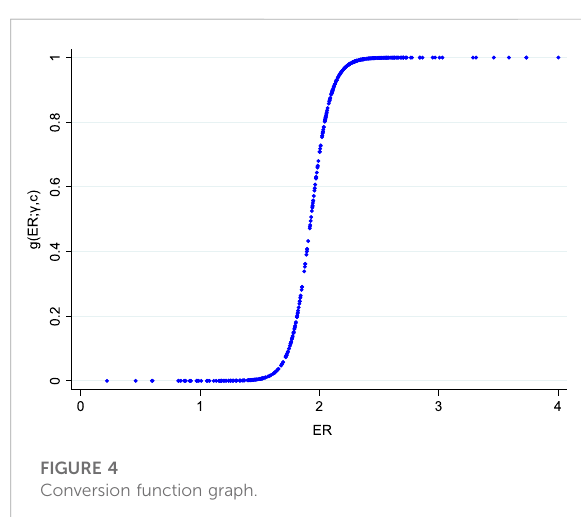
FIGURE 4 Conversion function